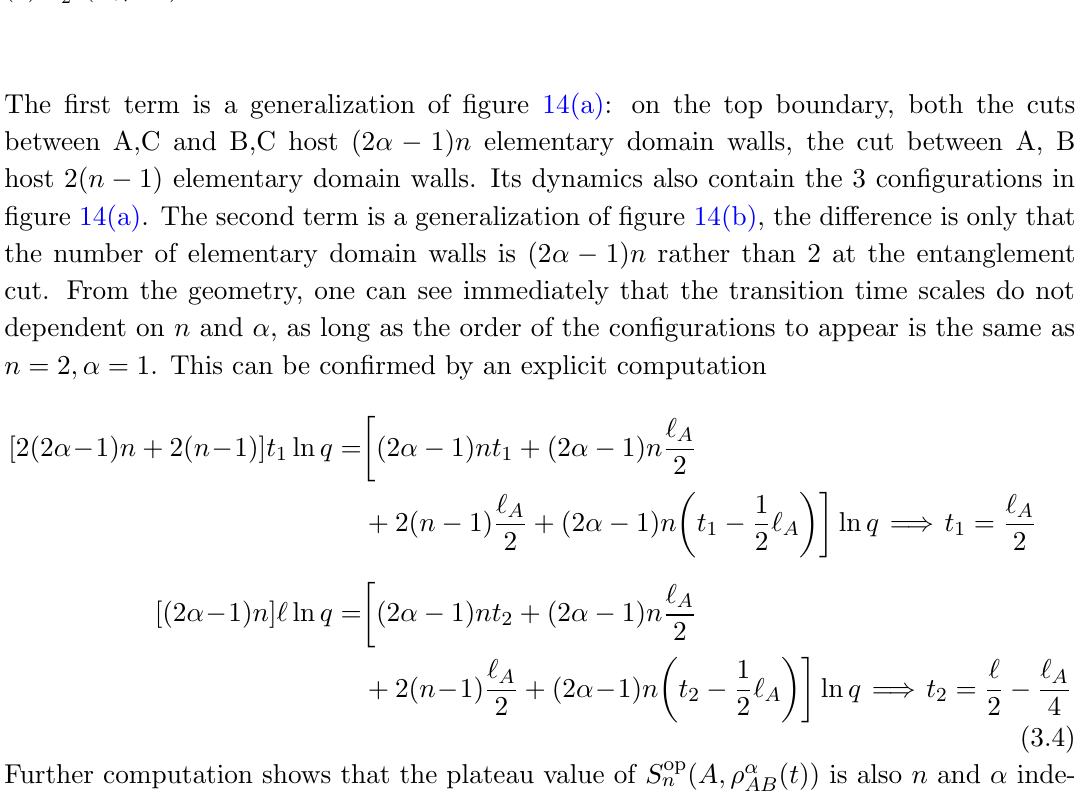
Figure 15 . S op ( A; (cid:26) AB ) when ‘ A = ‘ B = ‘ . (a) Operator entanglement as the di(cid:11)erence of two 2 2 terms in eq. (3.1). As analyzed in the text, the solid curve has transitions between 3 con(cid:12)gurations while the dashed curve representing the state entropy has only linear growth and saturation phases. (b) S op ( A; (cid:26) AB ) as a function of 2